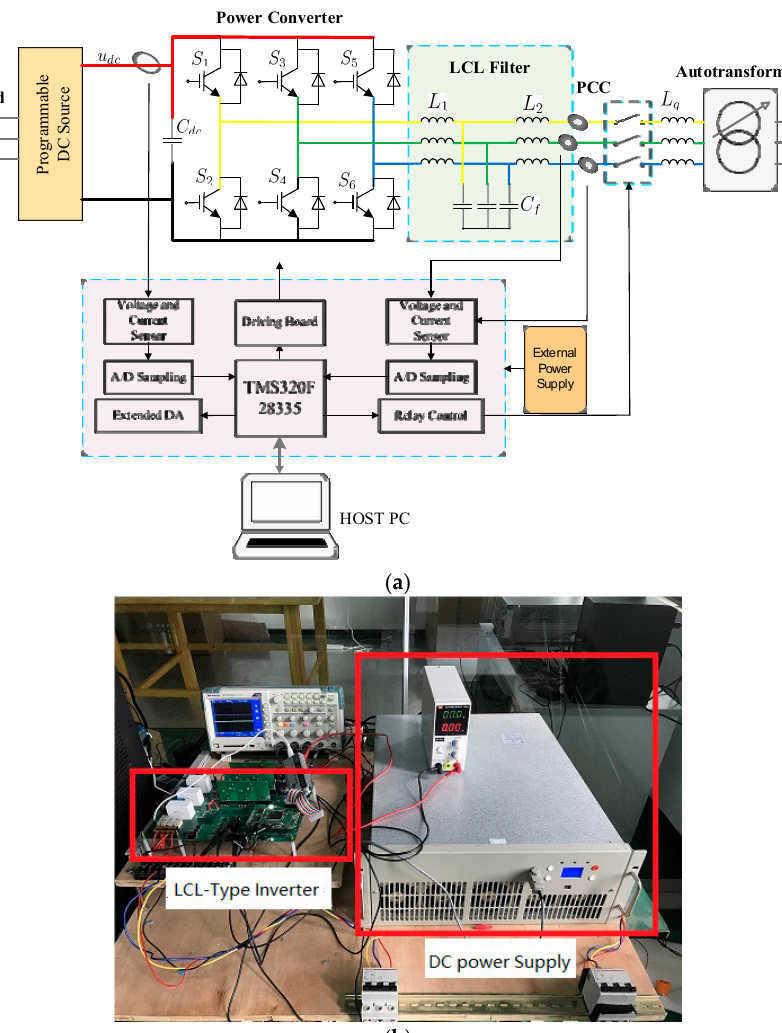
Figure 9. Experiment platform of the three-phase grid-connected inverter. ( a ) system configuration block diagram. ( b ) photograph of the three-phase inverter prototype.